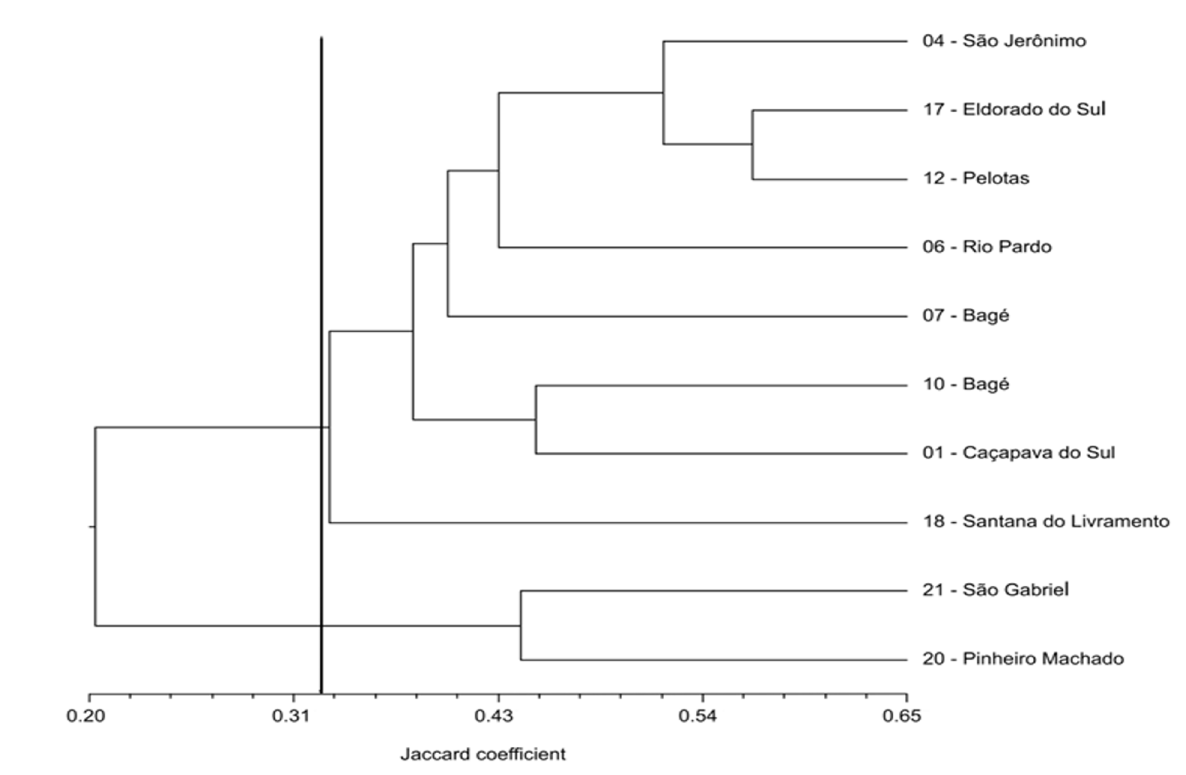
Figure 1 - Dendrogram of 10 T. polymorphum accessions revealed by UPGMA cluster analysis based on SSR markers data using Jaccard’s similarity